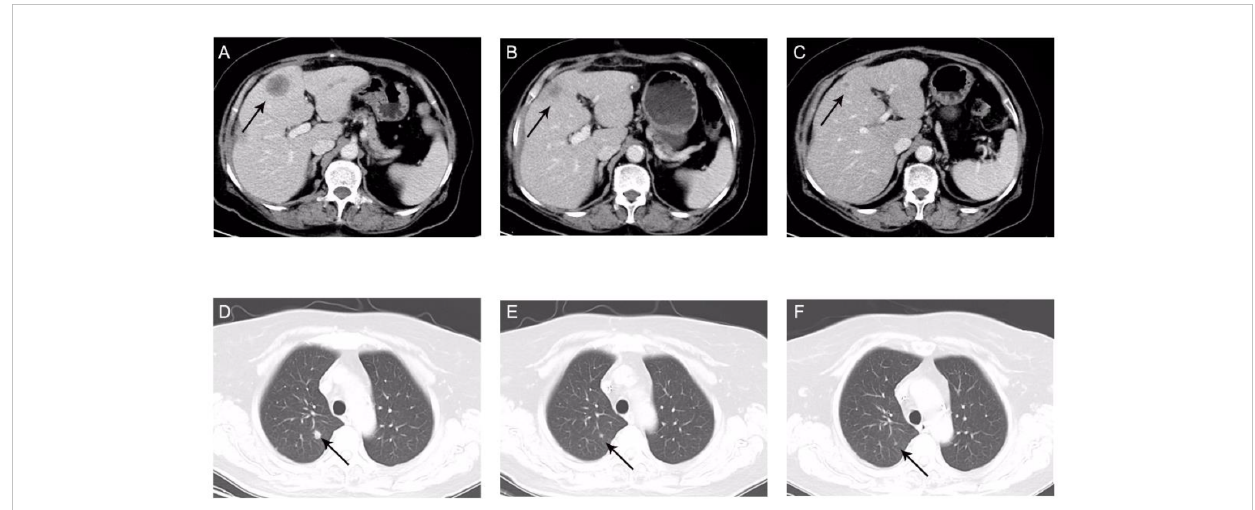
FIGURE 2 Computed tomography portal phase images. Maximum diameter of the liver (A – C) and lung (D – F) metastases. (A) 28.7 mm, before the combination therapy. (B) 18.46 mm, after two cycles of combination therapy. (C) 6.39 mm, after eight cycles of combination therapy. (D) Before combination therapy. (E) After two cycles of combination therapy. (F) After eight cycles of combination